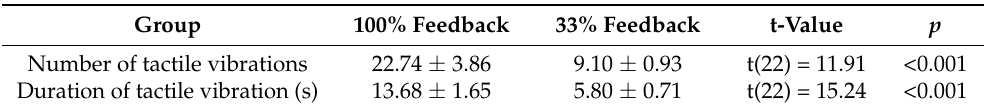
Table 3. Group means (±standard deviation) and statistics (i.e., t and p values) for the number and duration of tactile vibrations for the vibrotactile feedback condition.